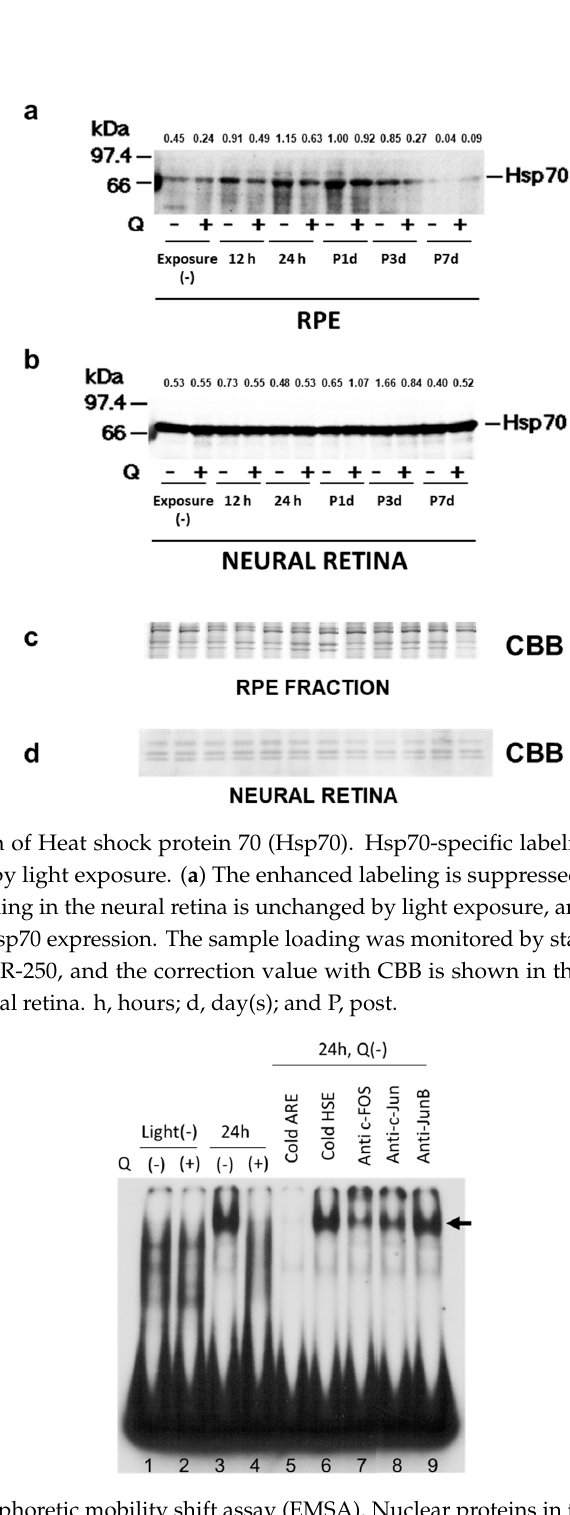
of detected bands (arrow) of the AP-1-protein binding complex, the samples were preincubated with 100-fold molar excess of cold AP-1 probe (lane 5) or cold heat shock element probe (lane 6), before the radio-labeled AP-1 probe was added. The samples were preincubated with antibodies for c-Fos (lane 7), c-Jun (lane 8), and JunB (lane 9) before the radio-labeled AP-1 probe was added. Q, quercetin; h, hours; ARE: Antioxidant-responsive Element; HSE: Heat Shock